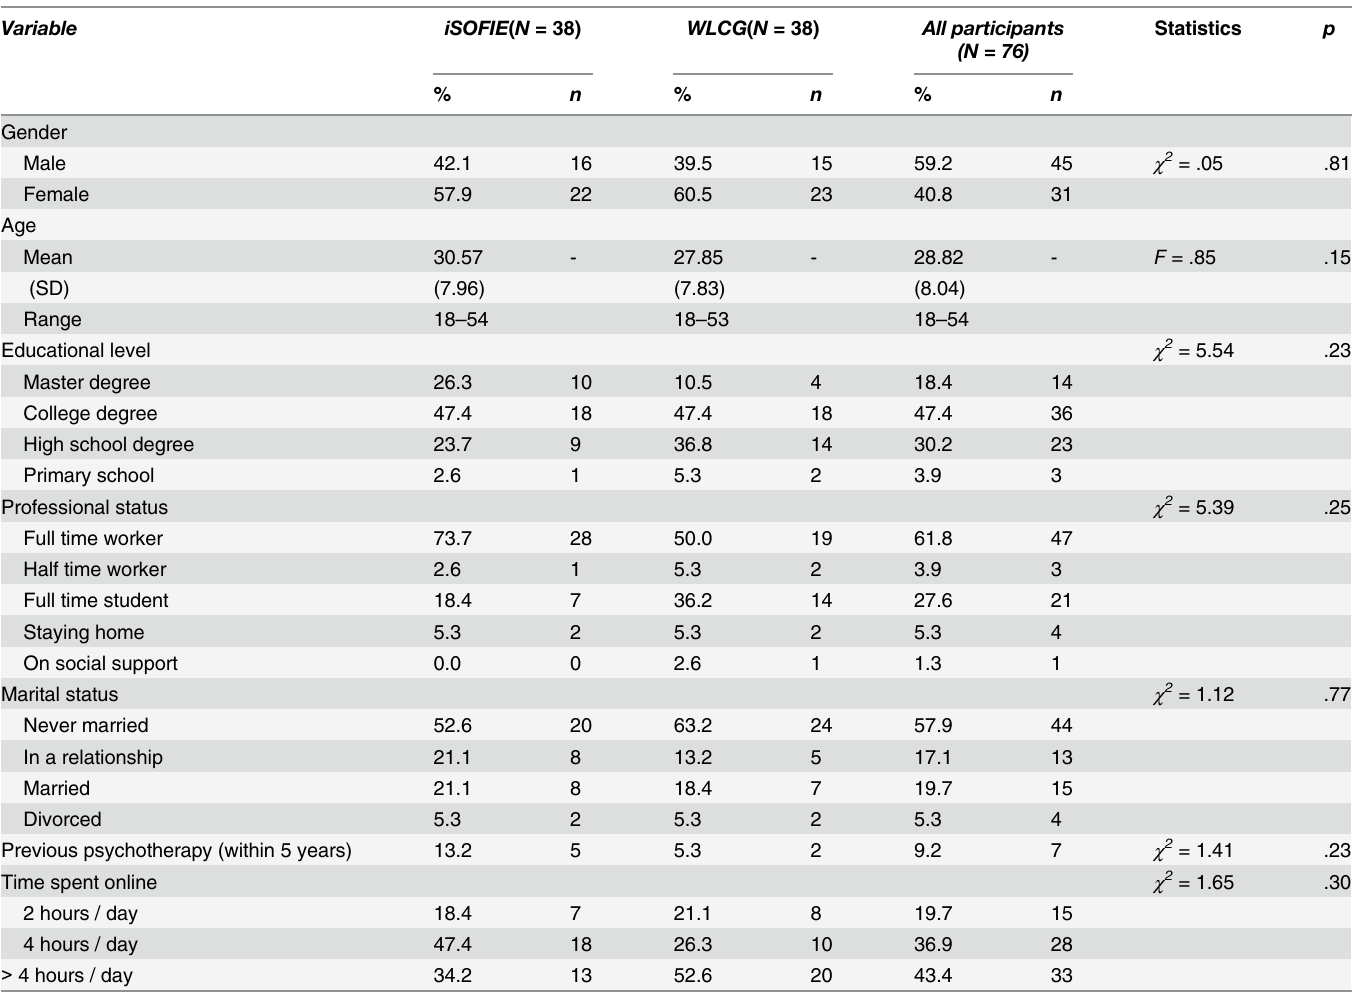
Table 1. Demographic characteristics of the two